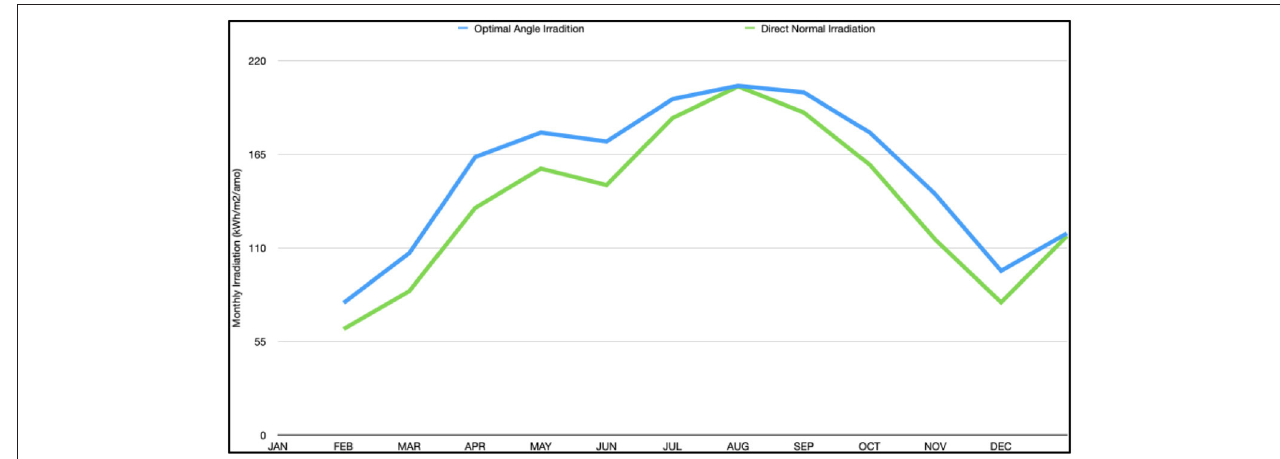
FIGURE 2 | Lisbon monthly solar irradiation estimates (2016) (adopted from JRC, 2021).